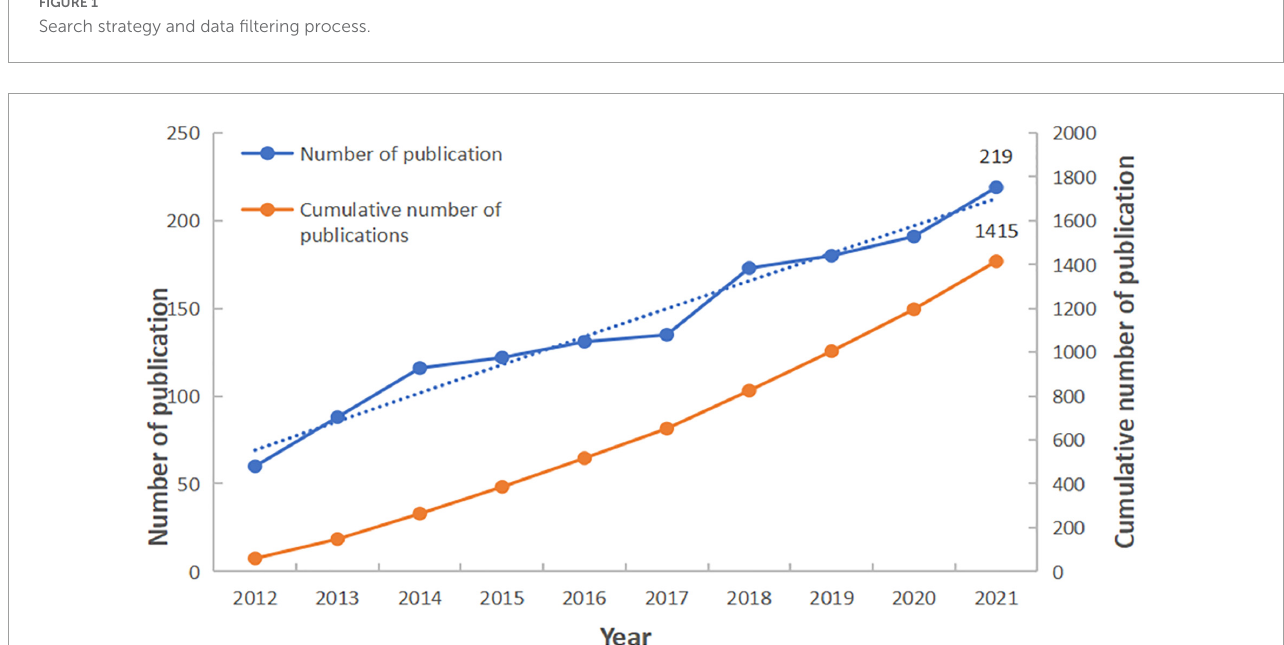
FIGURE2 The annual volume and trend of publications on the Mediterranean diet (MD) on